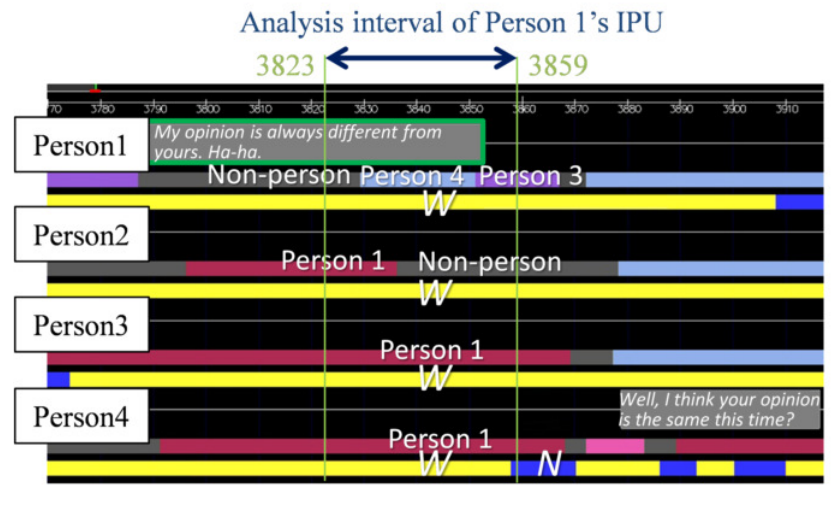
Figure 10. First sample situation where turn-changing occurs from Person 1 to Person 4. Upper gray boxes show IPUs, middle boxes show eye-gaze targets and lower boxes show the degrees of mouth-opening for each person along the